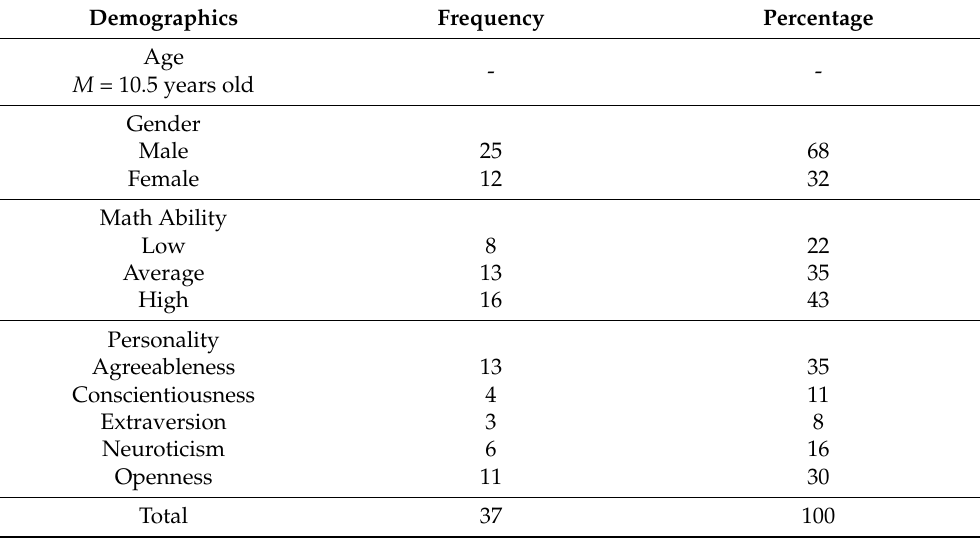
Table 1. The demographics of the participants in terms of their age, gender, math abilities, and personality dimensions. Most of the participants are male, have high mathematical abilities, and belong to the Agreeableness personality dimension.